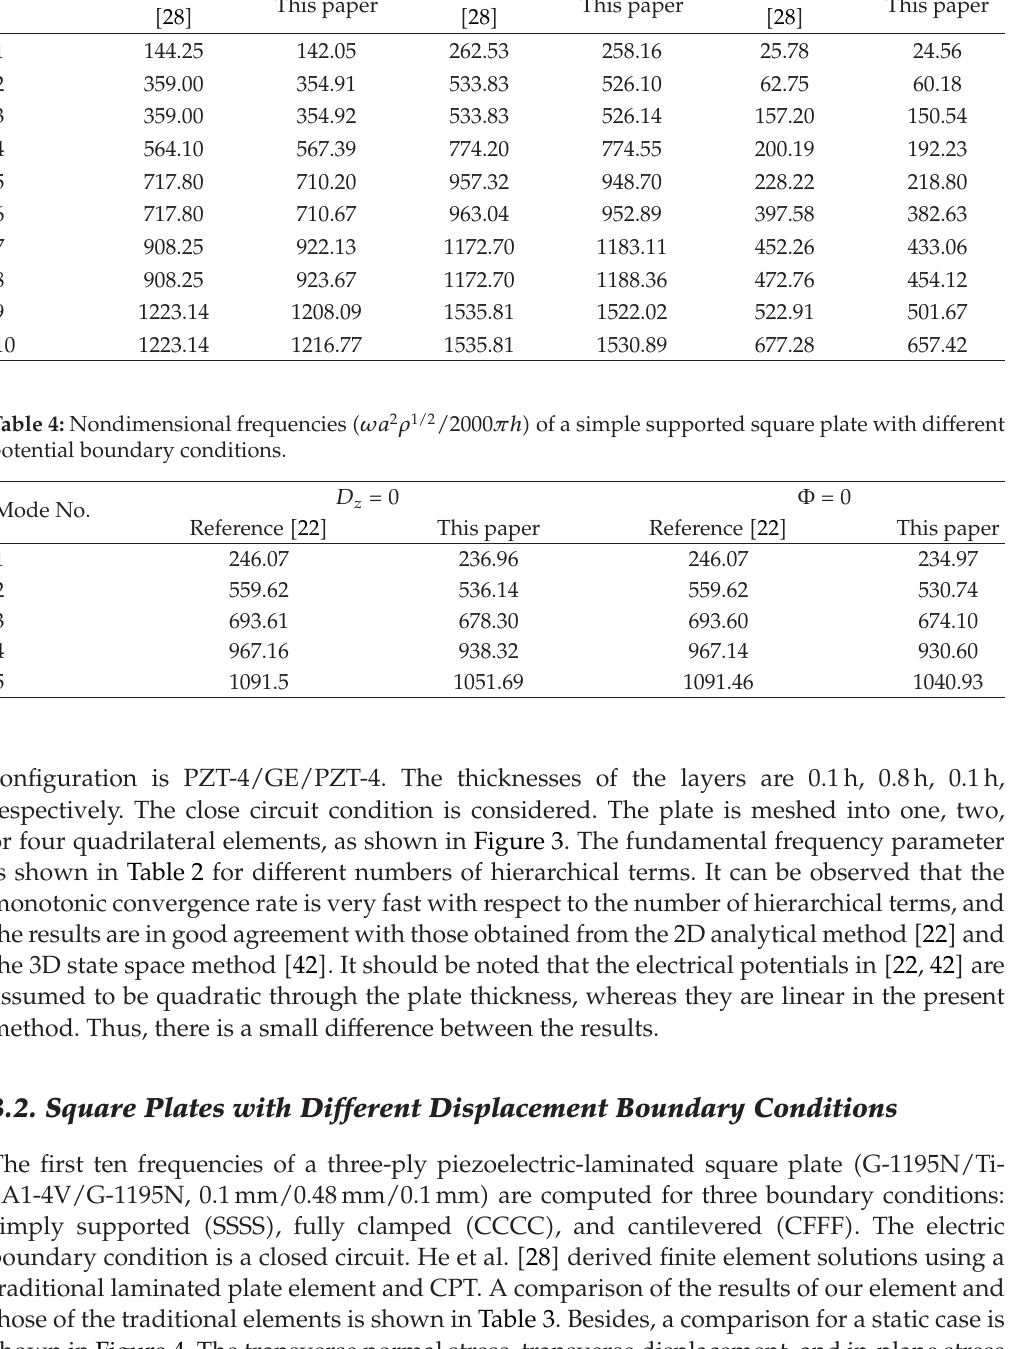
Table 3: Natural frequencies (cid:3) Hz (cid:6) of a three-ply square plate (cid:3) a (cid:8) 0 . 4 m, Φ (cid:8) 0 (cid:6) . Mode No.